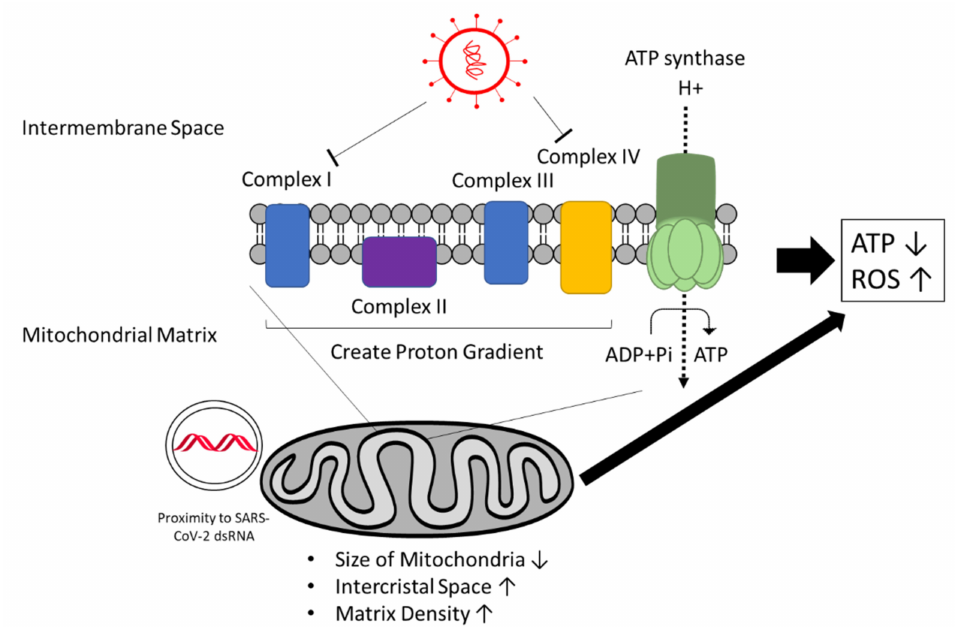
Figure 8. SARS-CoV-2 manipulates energy metabolism. SARS-CoV-2 affects the morphology of mitochondria and components of the respiratory chain. A decrease in ATP and an increase in ROS production is observed, which could be the result of altered mitochondria function and respiratory chain activity. ATP, adenosine triphosphate; ROS, reactive oxygen